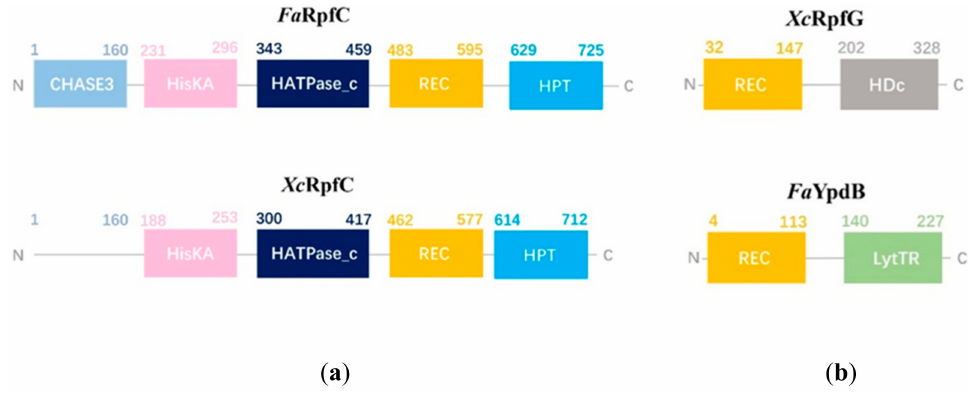
Figure 6. Comparison of domain arrangements of RpfC ( a ) and its cognate response regulator ( b ) in IK-1 T and Xanthomonas campestris